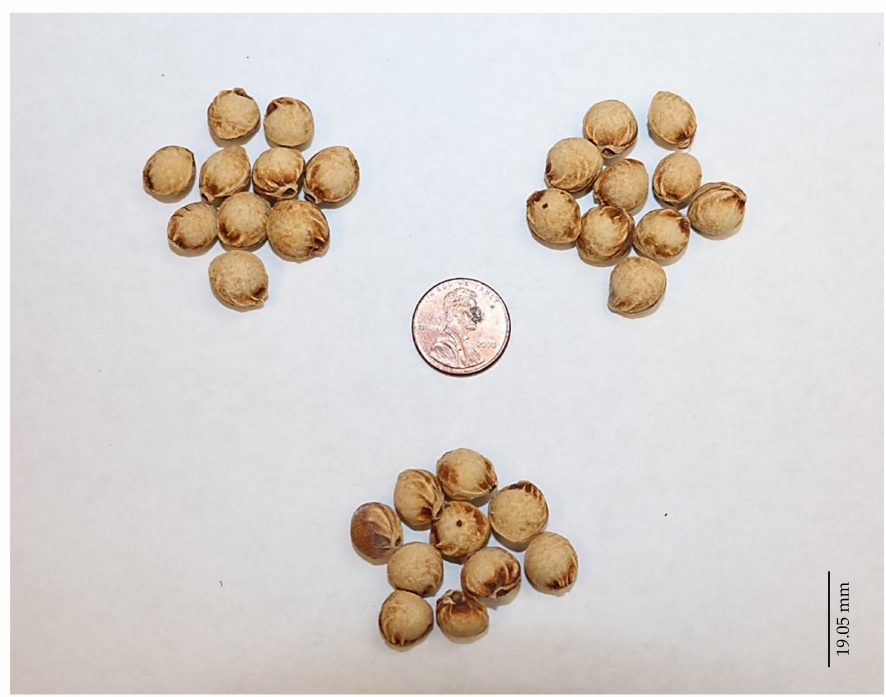
Figure 3. Endocarps of Prunus serotina subsp. capuli genotype PserTU77, collected in the Andes region of Ecuador in 2016. A US one cent coin was used as a size reference (diameter 19.05